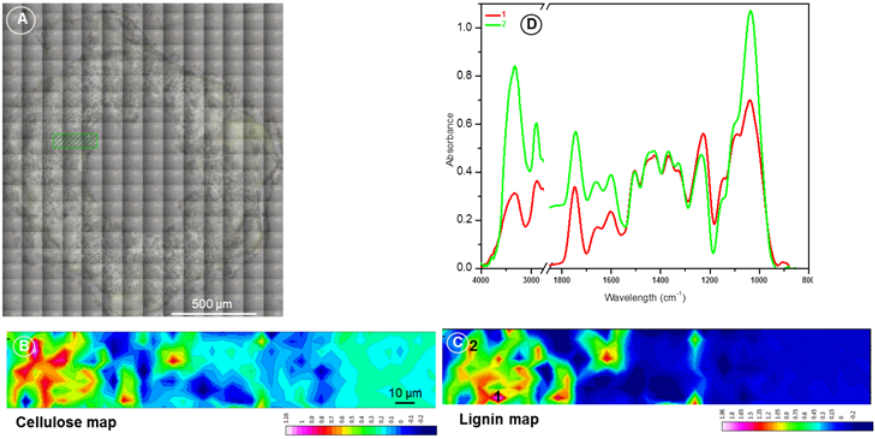
Fig 6. Visible (A) and FT-IR spectromicroscopy (B-D) of lentil stem section. Visible image of the entire lentil stem section (A) cut for FT-IR spectromicroscopy. The cellulose (B) and lignin (C) IR maps together with the spectra extracted (D) from two regions are